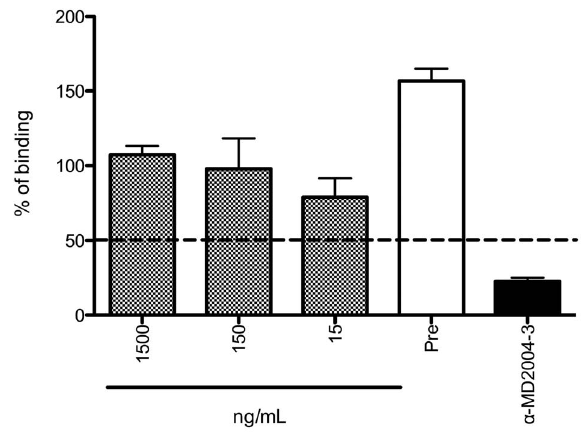
Figure 5. MAb TV20 fails to block the binding of GII.4 VLPs with histo-blood group antigens (HBGA). Percent binding of MD2004-3 (GII.4 strain) VLPs to B carbohydrate in the presence of different concentrations of MAb TV20 was calculated as described in Materials and Methods . Pre-immune sera and hyperimmune sera ( a - MD2004-3) from immunized guinea pigs were used as negative and positive control, respectively. Error bars represent the S.E.M. Dashed line represents the 50% blocking cut-off